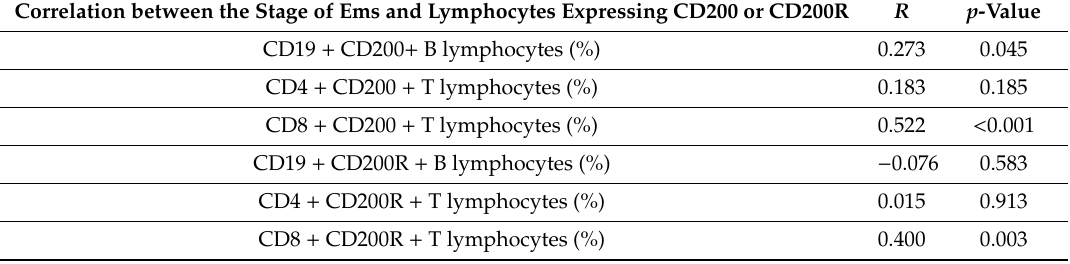
Table 6. Correlations between the stage of the disease and lymphocytes expressing CD200 or CD200R. Correlation between the Stage of Ems and Lymphocytes Expressing CD200 or CD200R R